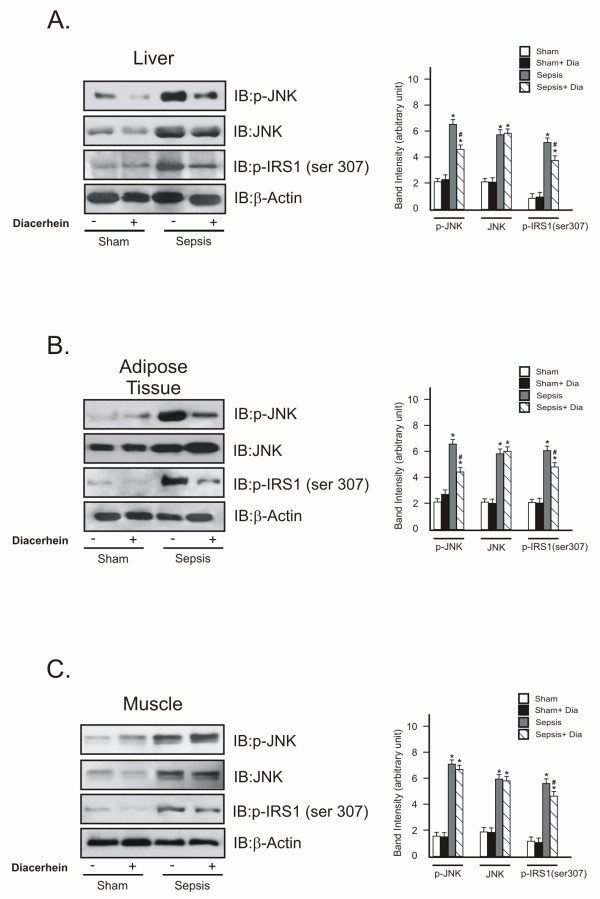
Effects of diacerhein treatment on the JNK pathway signaling in the CLP rat. Representative blots show the JNK phosphorylation, total protein expression of JNK, and serine 307 phosphorylation of IRS1 in liver (A), adipose tissue (B), and muscle (C) of sham and septic rats. Blots were stripped and reprobed with β-actin (lower panels) to confirm equal loading of proteins. Data are presented as mean ± SEM from six to eight rats per group. *P < 0.05 versus Sham/Vehicle; #P < 0.05 (Sepsis/Veh versus Sepsis/Dia). IB, immunoblot; Sham, Sham/Vehicle; Sham+Dia, Sham/Diacerhein; Sepsis, Sepsis/Vehicle; Sepsis+Dia, Sepsis/Diacerhein.